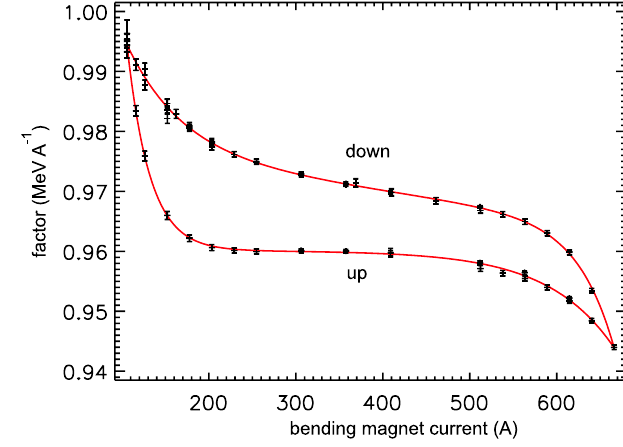
FIG. 8. (Color) Proportionality factor between bending magnet current and electron beam